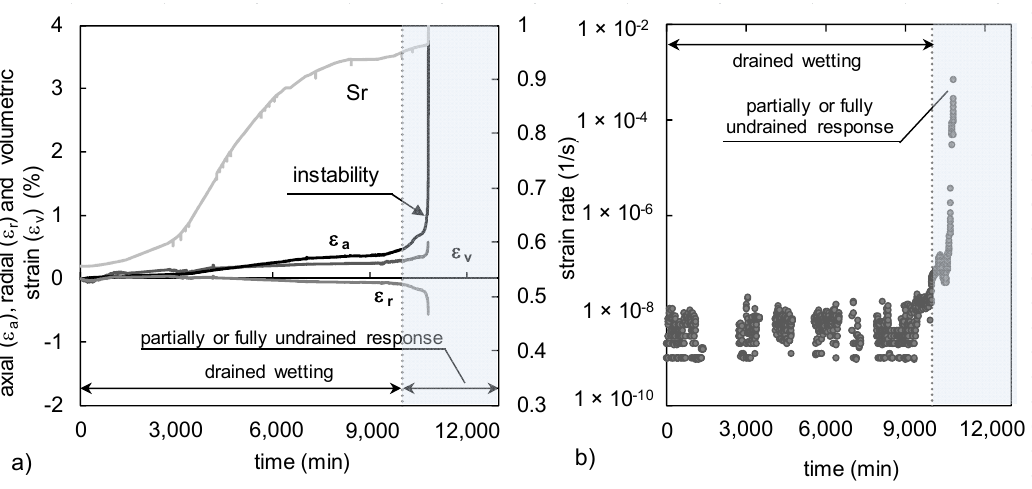
Figure 4. Results of a wetting test characterized by an initial suction of 82 kPa in terms of: ( a ) axial, radial, volumetric strains, and degree of saturation evolution; ( b ) deviatoric strain rate evolution.